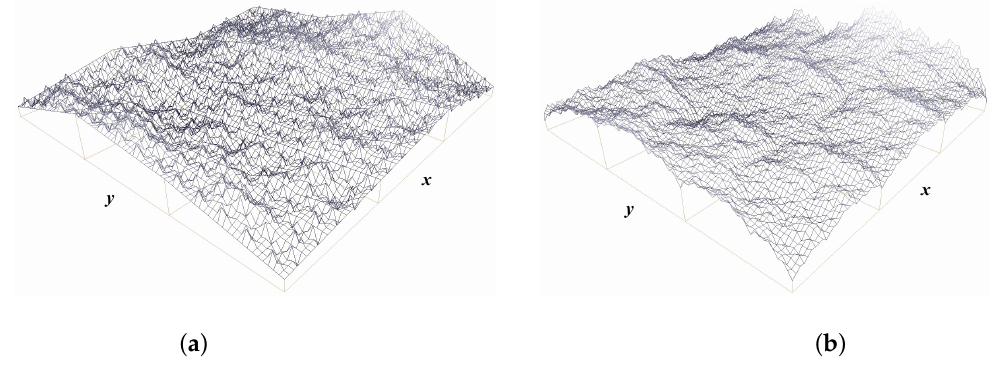
Figure 12. ( a ) The surface constructed with the original set of data. ( b ) The fractal interpolation